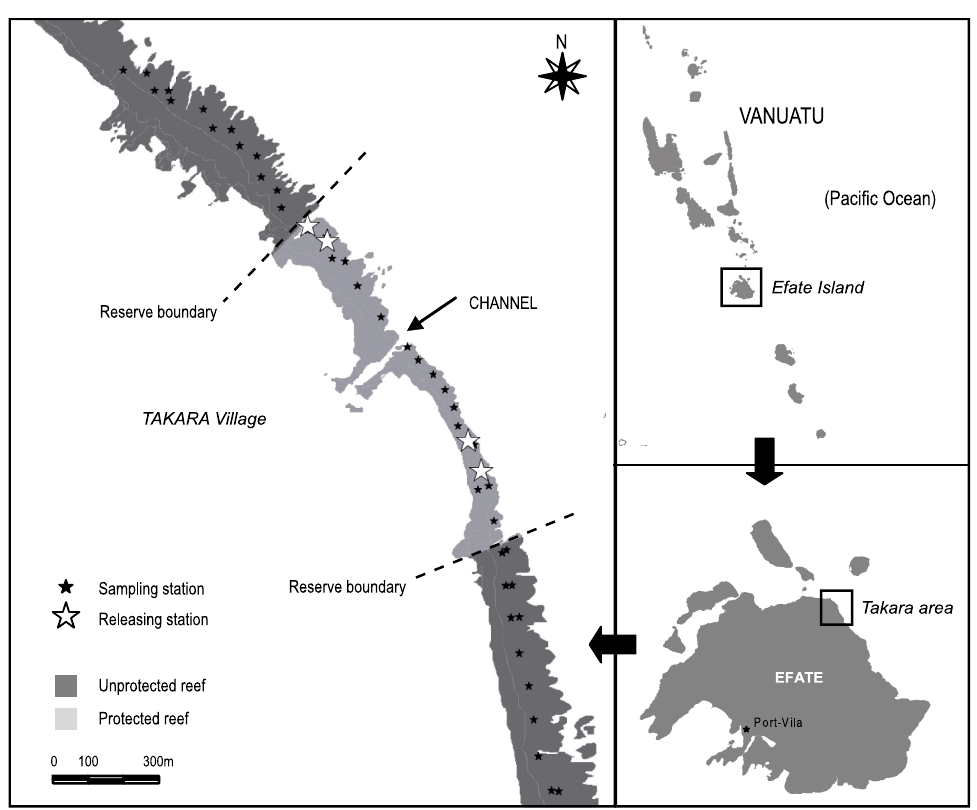
Fig 1. Location of the study area in North Efate, Vanuatu (South Pacific). Boundaries of the Takara marine reserve, reef samplingand trochus taggingrelease stations are